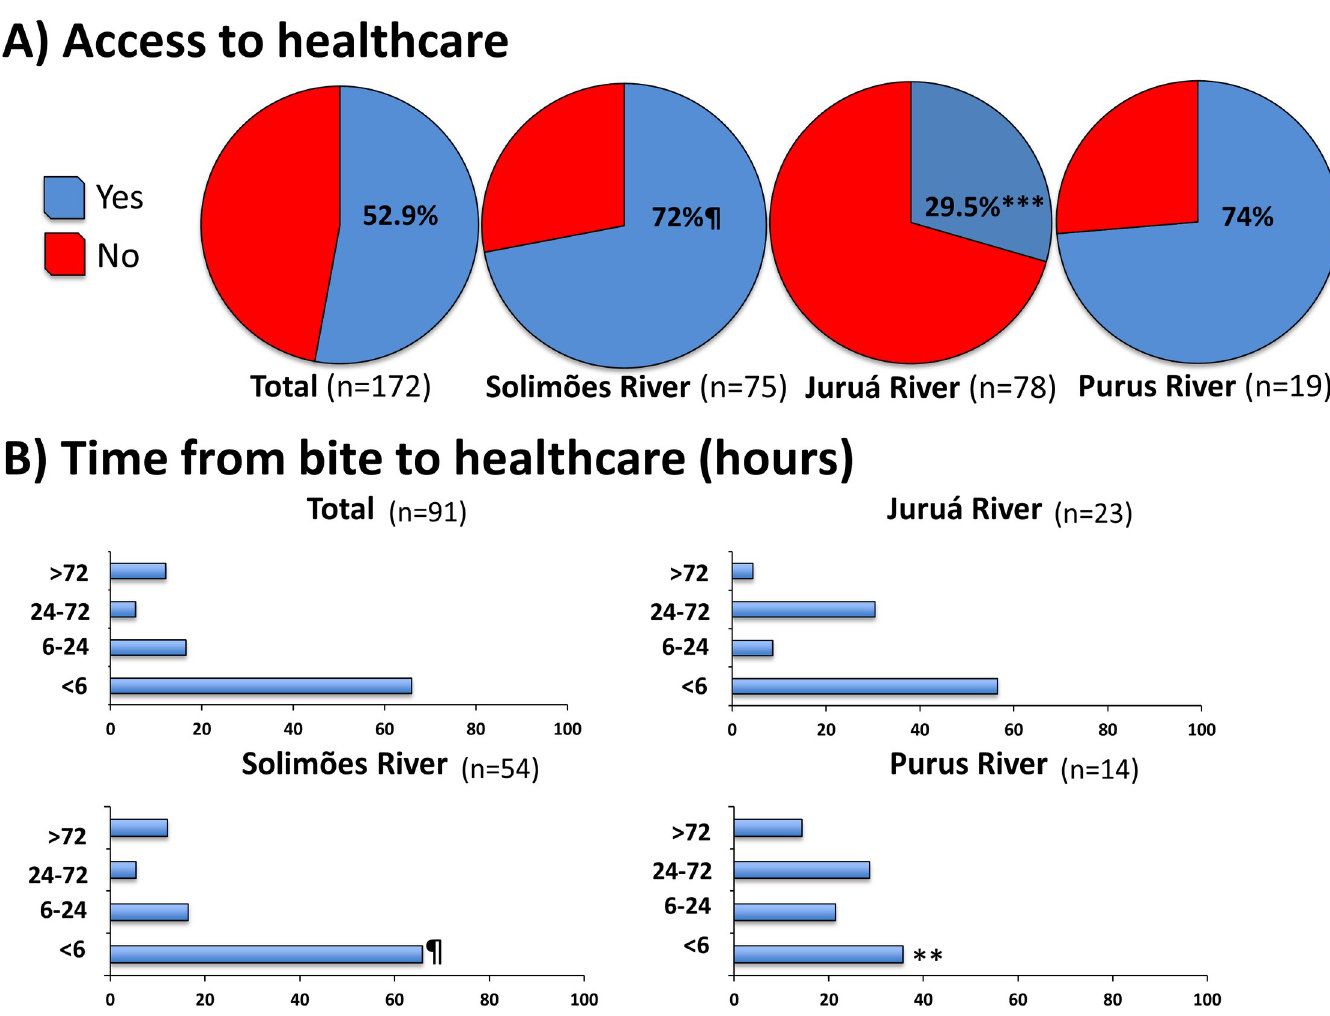
Fig 3. Access to healthcare (A) and time elapsed from snakebite to healthcare (hours) (B) according to three river basins. ¶ Reference group for statistical comparisons by Chi-square test (corrected by Fisher’s exact test if necessary); � p < 0.05; �� p < 0.005; ��� p < 0.0005; § Information was not provided by two participants.